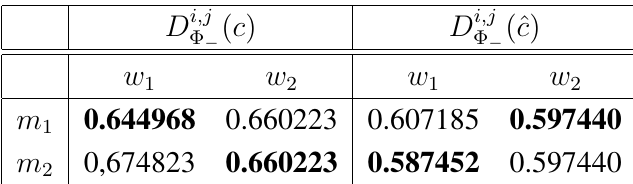
Table 2. Divorce Probabilities in Example 2 (Probabilities for Matched Pairs in